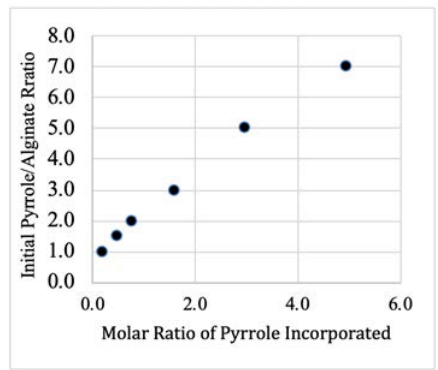
Figure 3. Incorporation of pyrrole into PPy–Alg composites prepared from solutions with different molar rations of pyrrole to alginate. Data based on combustion analysis. Compositions from lowest to highest PPy content are referred to as composites B–F, respectively.